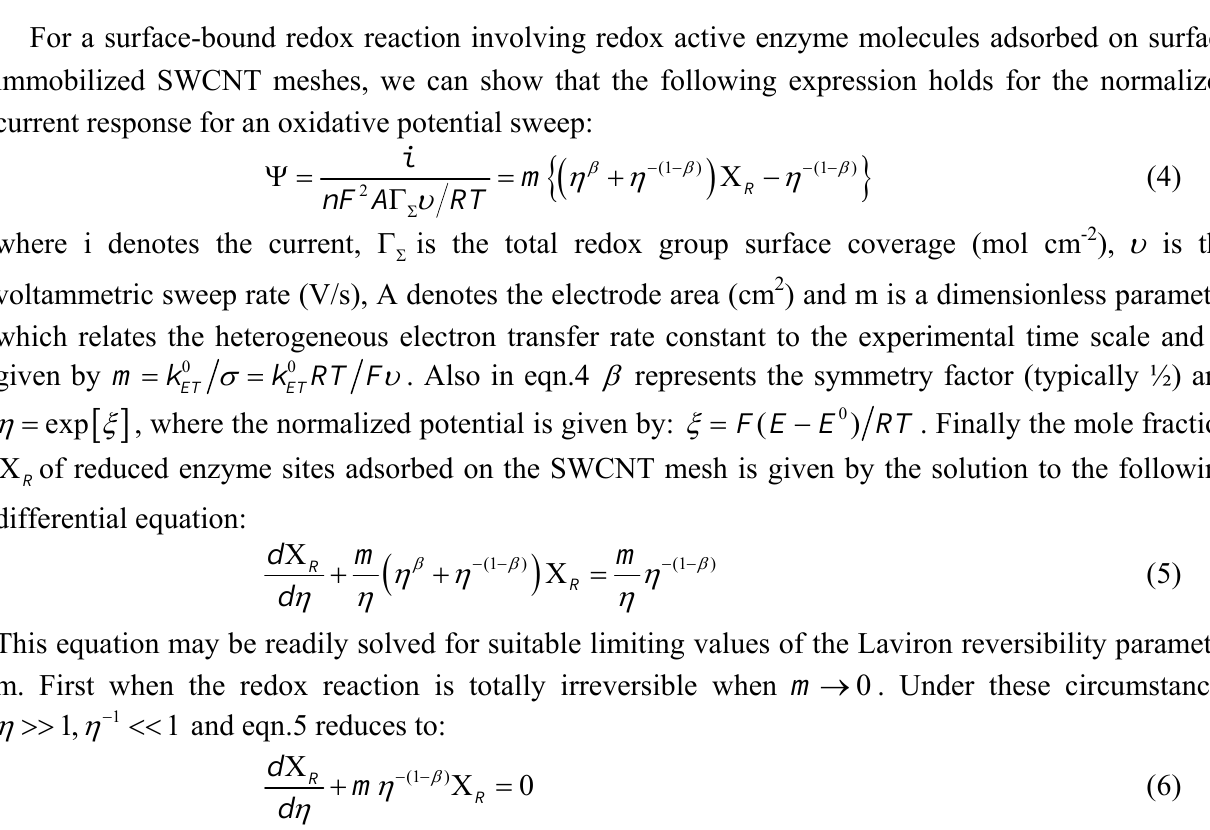
Figure 16. Plots of anodic and cathodic peak potentials against the natural logarithm of scan rate for a SWCNT/GOx/Nafion-modified gold working electrode. The electrolyte used was a 50 mM phosphate buffer (pH